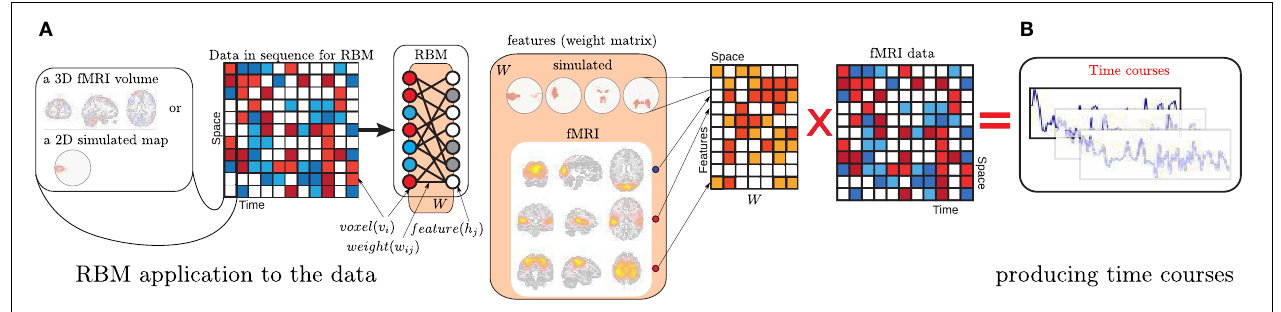
FIGURE 1 | (A) An illustration of how an RBM is applied to the data as well as a graphical representation of RBM’s structure. (B) Demonstrates the way we produce time courses from the data and learned features, which is simply a